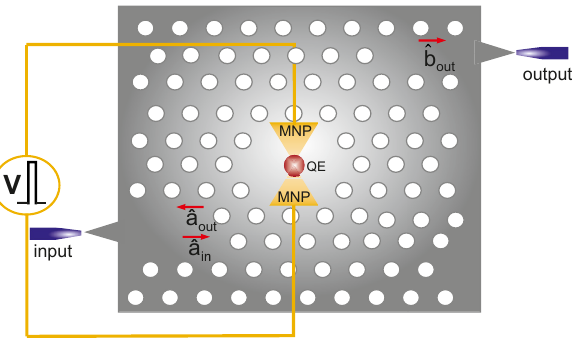
Figure 1: Micron-scale, voltage-tunable integrated entanglement device. Nonlinearity of the MNS is already extremely enhanced due to localization at the hotspot [41]. QE(s) positioned to the hotspot induces a Fano resonance which can suppress (turn off) the localization-enhanced = 2 𝜔 or enhance it 10–100 times at nonlinearity by several orders at 𝜔 QE ≈ 2.002 𝜔 . Level-spacing ( 𝜔 around 𝜔 ) is tuned by an applied voltage QE QE ̂ is the input field (integrated laser), ̂ a and b are the [26, 30–33]. ̂ a in out out output fields whose entanglement (Figure 4a) and non-classicality (Figure 4b) are investigated.